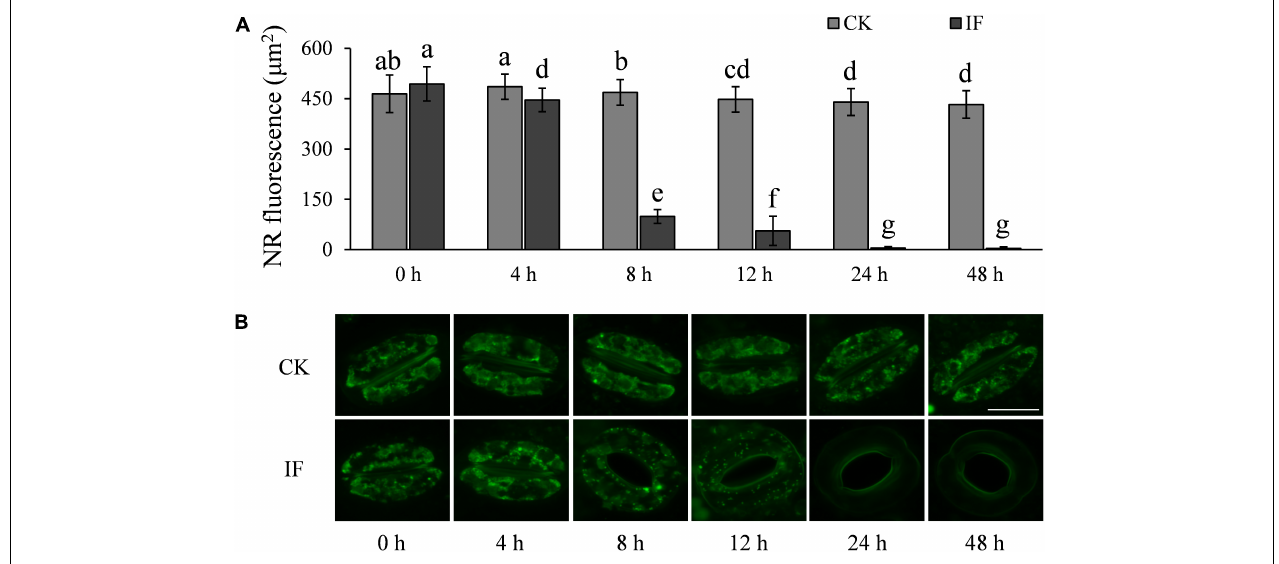
FIGURE 6 | P. infestans -induced stomata opening correlates with TAG breakdown in guard cells: (A) TAGs in the guard cells of P. infestans- infected (IF) potato leaves started to decrease significantly 8 hpi; and (B) images showing the volume of TAGs in guard cells of the P. infestans -infected (IF) and not-infected (CK) potato leaves. The marker = 20 µ m. Photos within a panel are from a representative of a single replicate while photos among panels are pooled from multiple